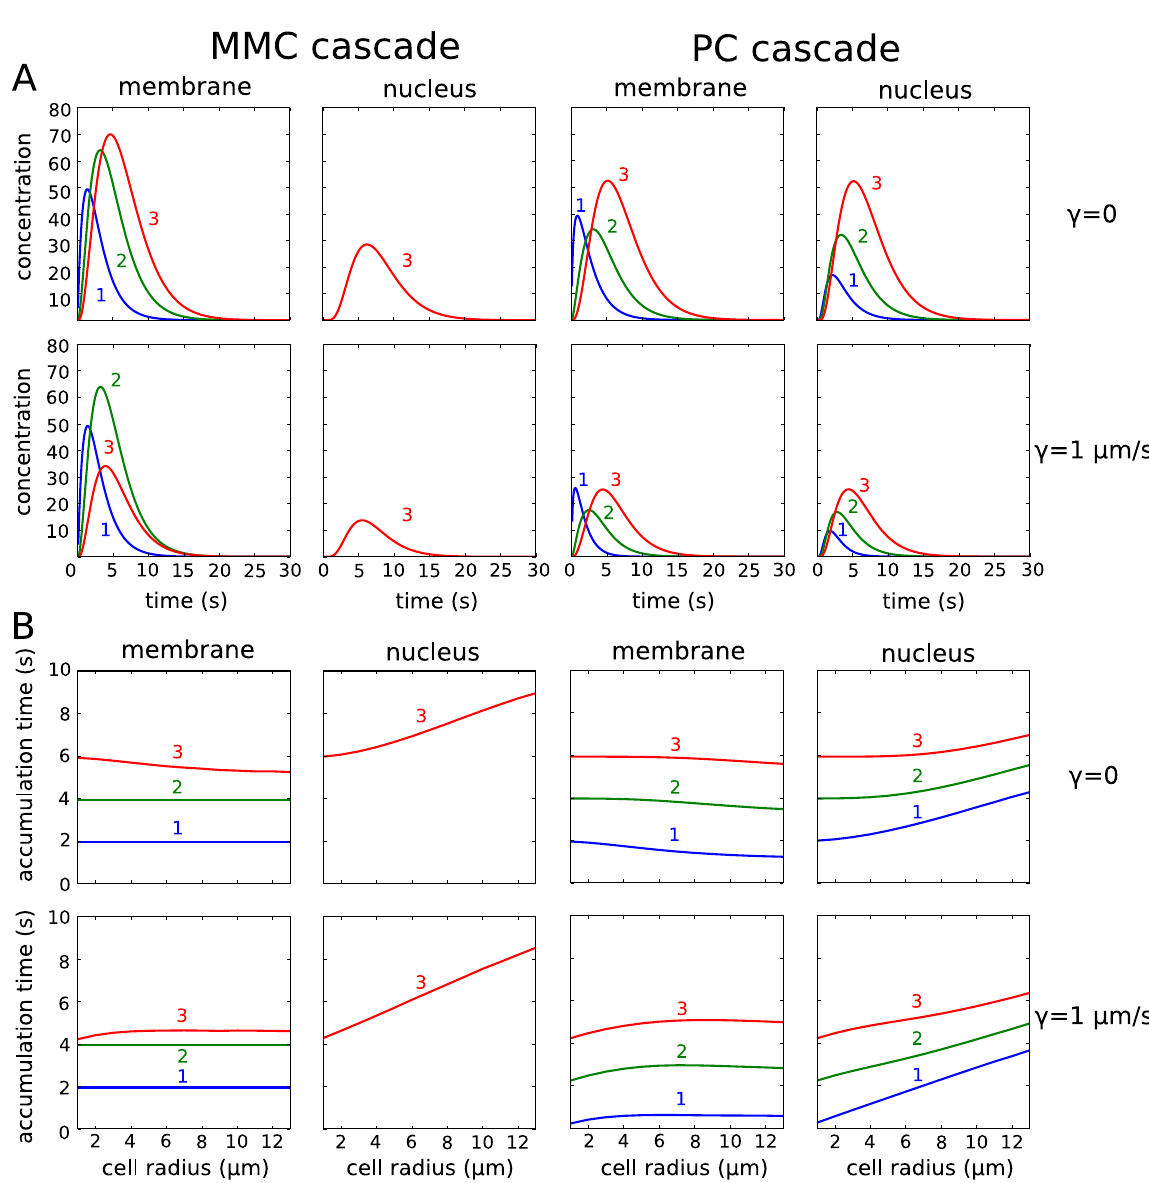
Fig 4. Timing of spatial signaling. The signaling time for the mixed membrane-cytosolic (MMC) cascade [left] and pure cytosolic (PC) cascade [right] at the membrane and at the nucleus was simulated. ( A ) Time course for the concentrations of P 1 , P 2 and P 3 after stimulation with a time- dependent signal P ð ~ x ; t Þ ¼ P max ¼ 100 n M m m was plotted. The cascade levels are indicated by the numbers. Note that in exp ð(cid:0) l t Þ and P max 0 0 0 case of the MMC, the concentrations for